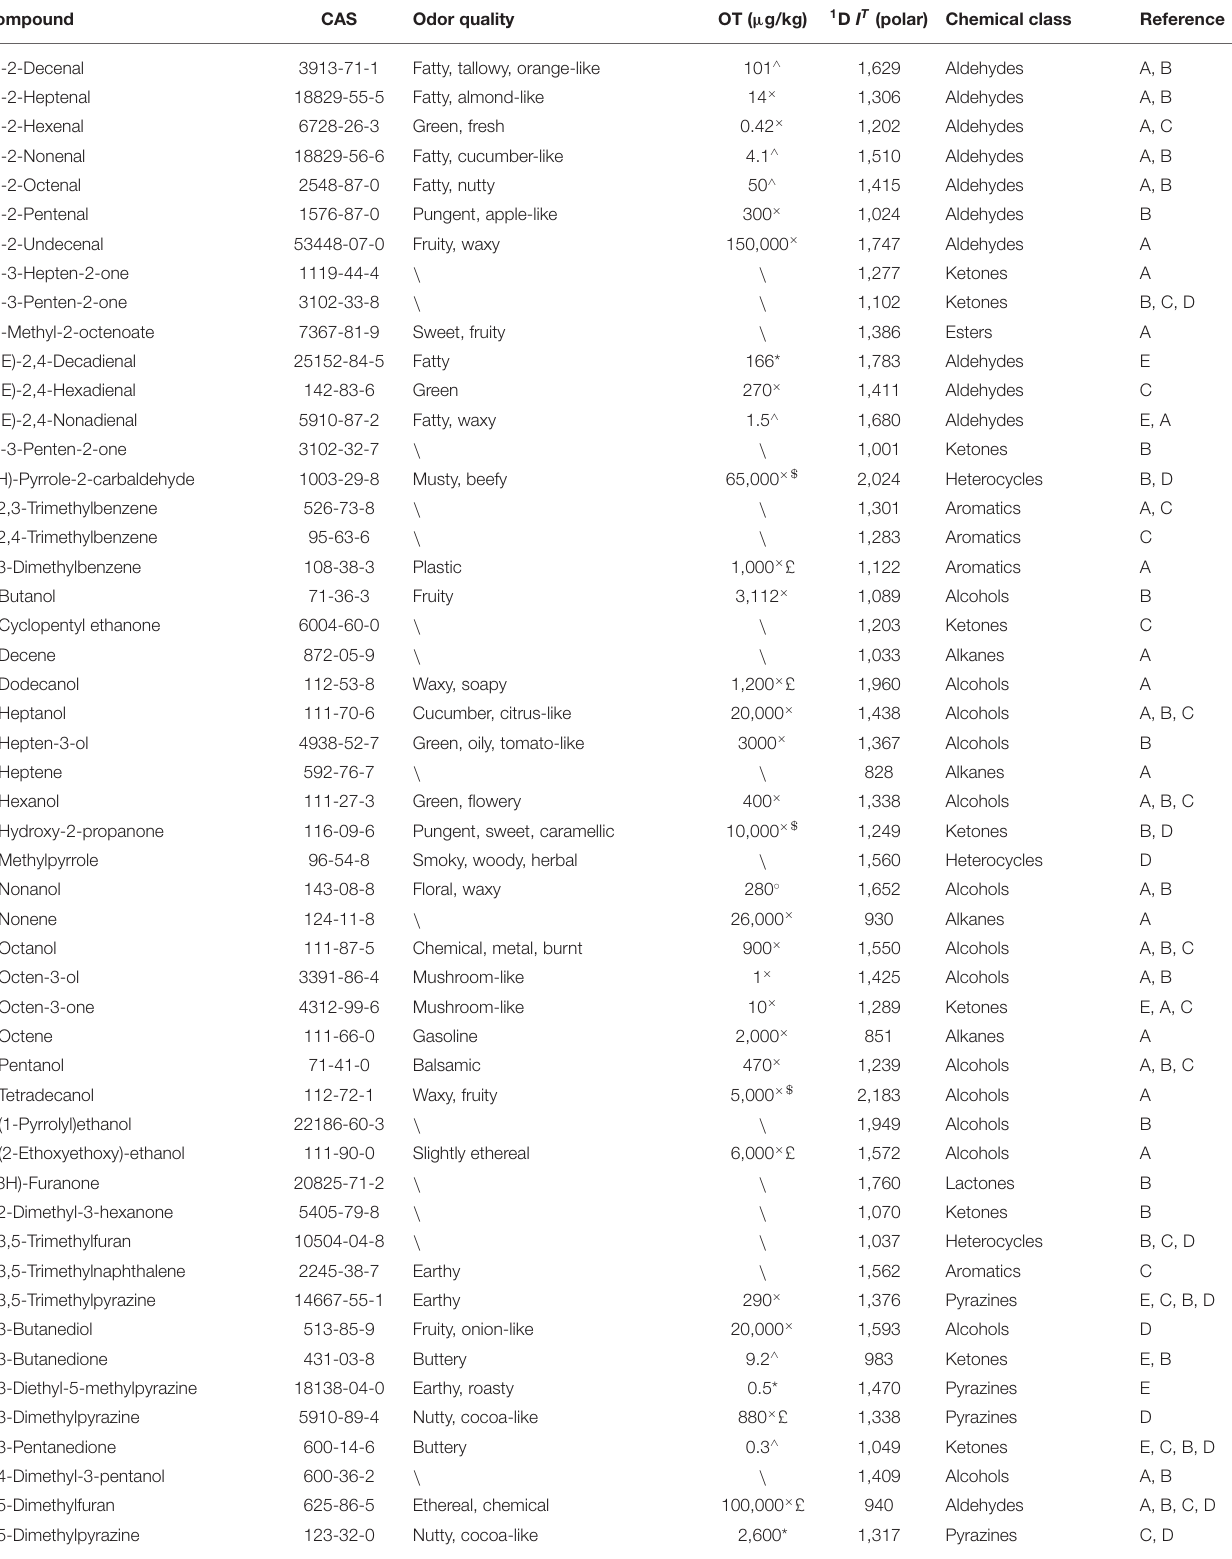
TABLE 5 | Volatilome composition detected in raw and roasted hazelnut